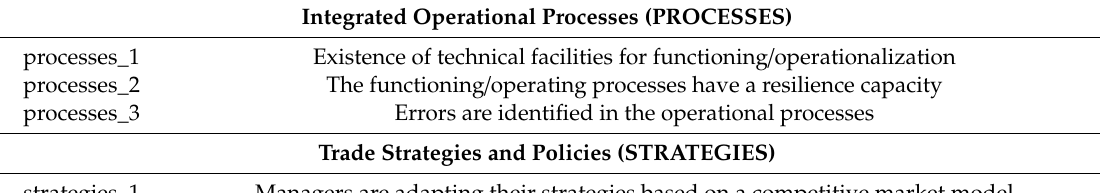
Table 1. Description of the independent (formative) variables.